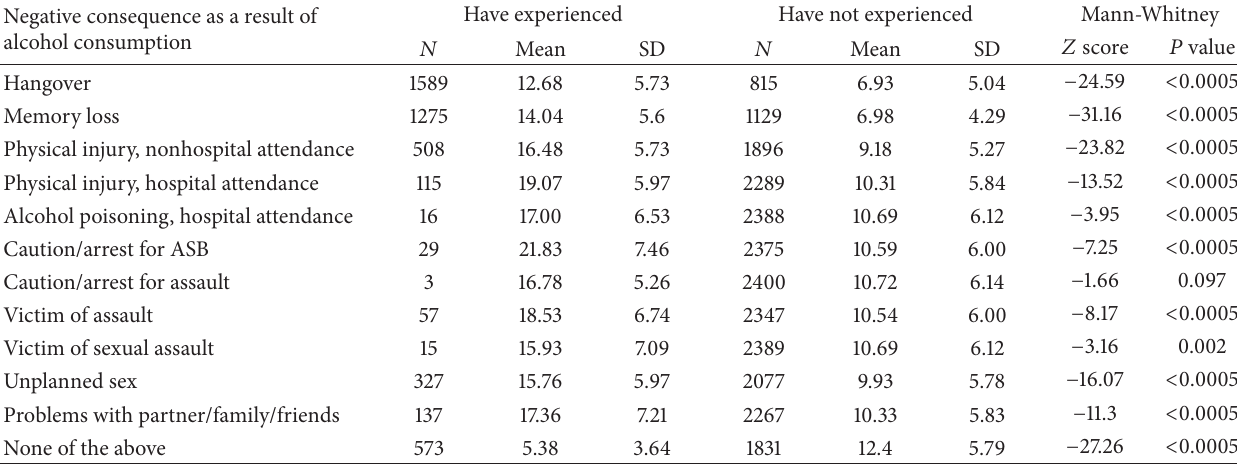
Table 4: Differences in AUDIT score in relation to negative consequences of